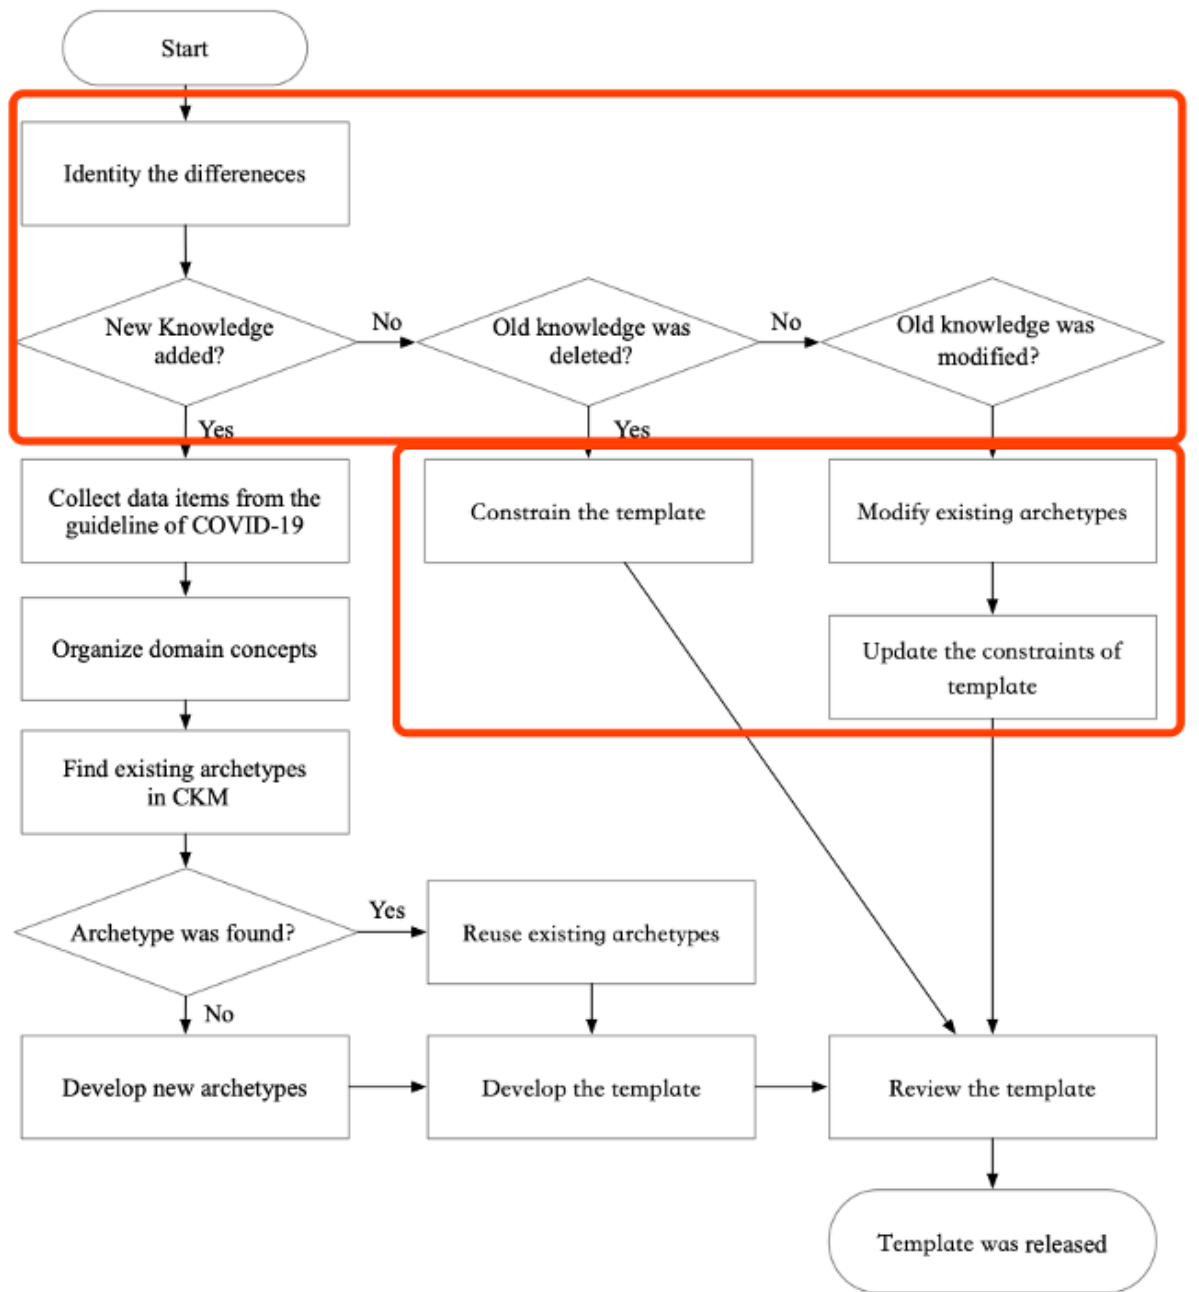
Figure 6. The updating process of the template. CKM: Clinical Knowledge Manager; COVID-19: coronavirus